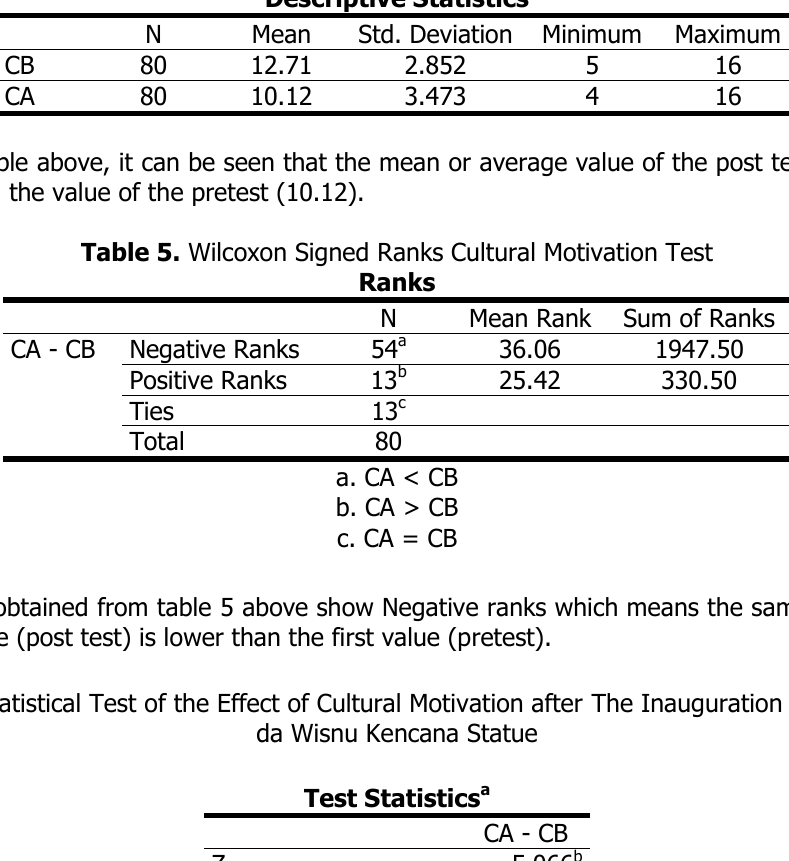
Table 4. Descriptive Statistics of Cultural Motivation